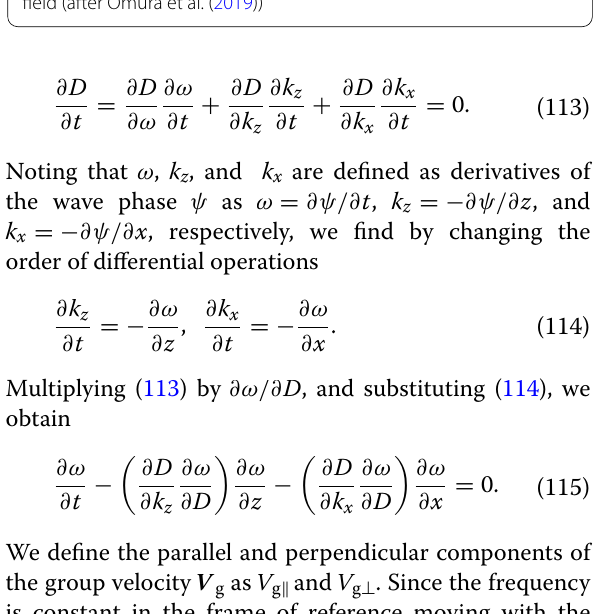
Fig. 13 Properties of oblique whistler-mode waves. a Angles of group velocity vector V g as functions of frequency for different wave normal angles [after Hsieh and Omura (2017)]. b Difference of phase velocity and group velocity as functions of frequency ω and the wave normal angle θ kB (after Hsieh and Omura